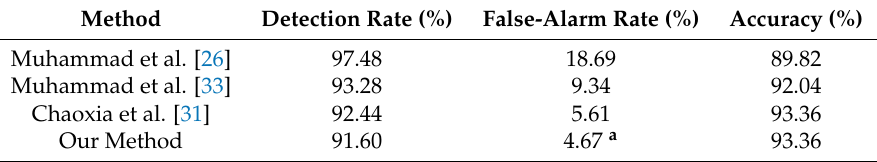
Table 5. Comparison with Other Methods.